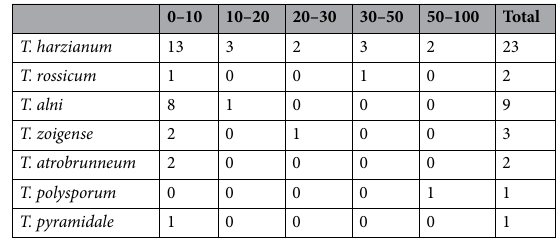
Table 4. Isolation frequency of Trichoderma species in different soil layers (%)